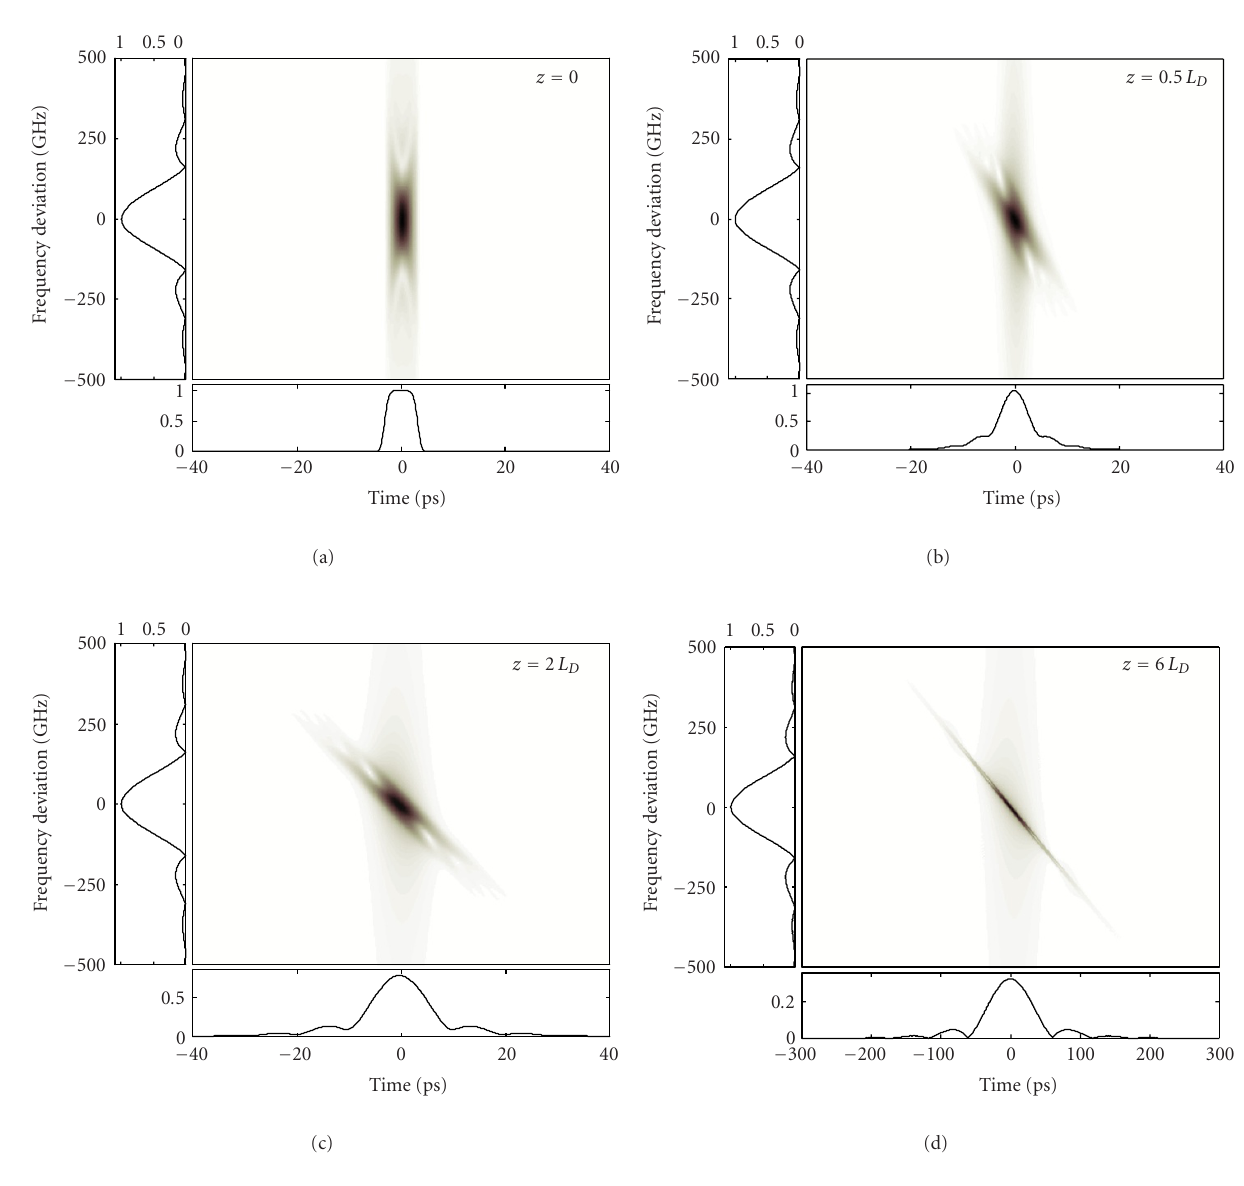
Figure 1: Wigner analysis of linear pulse propagation in an optical fiber (first-order